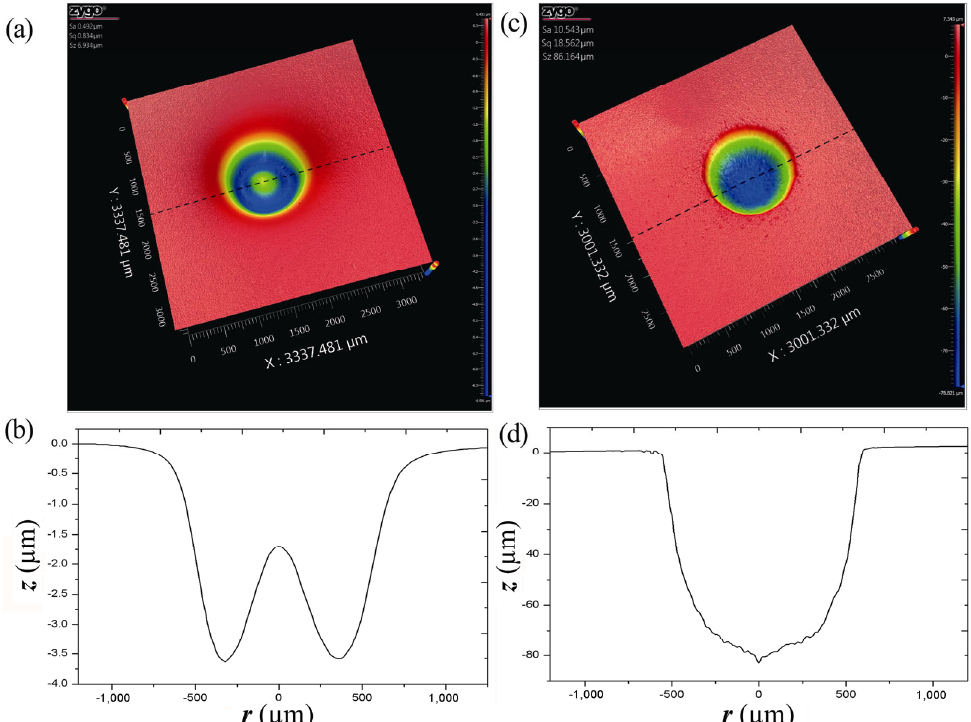
Fig. 3 The measured profiles of the material removal on the polished surface after impact. (a) Three-dimensional view and (b) cross section of the material removal when the diameter of the abrasive particles is 500 nm. (c) Three-dimensional view and (d) cross section of the material removal when the diameter of the abrasive particles is 2